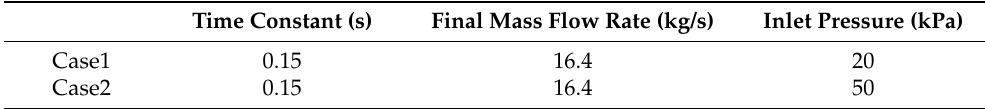
Figure 7. Grid interfaces at the inlet and exit of the impeller. Table 2. Two startup conditions.